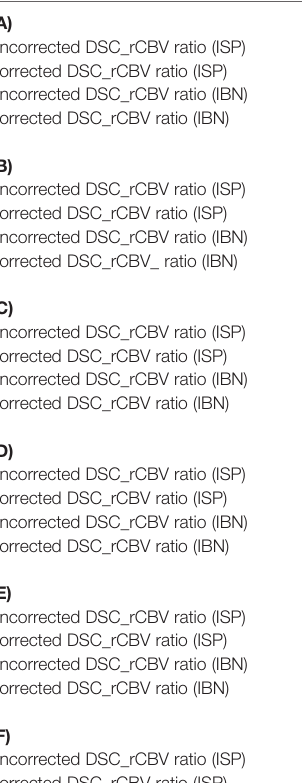
TABLE 3 | Correlation coef fi cients of lesion measurements.